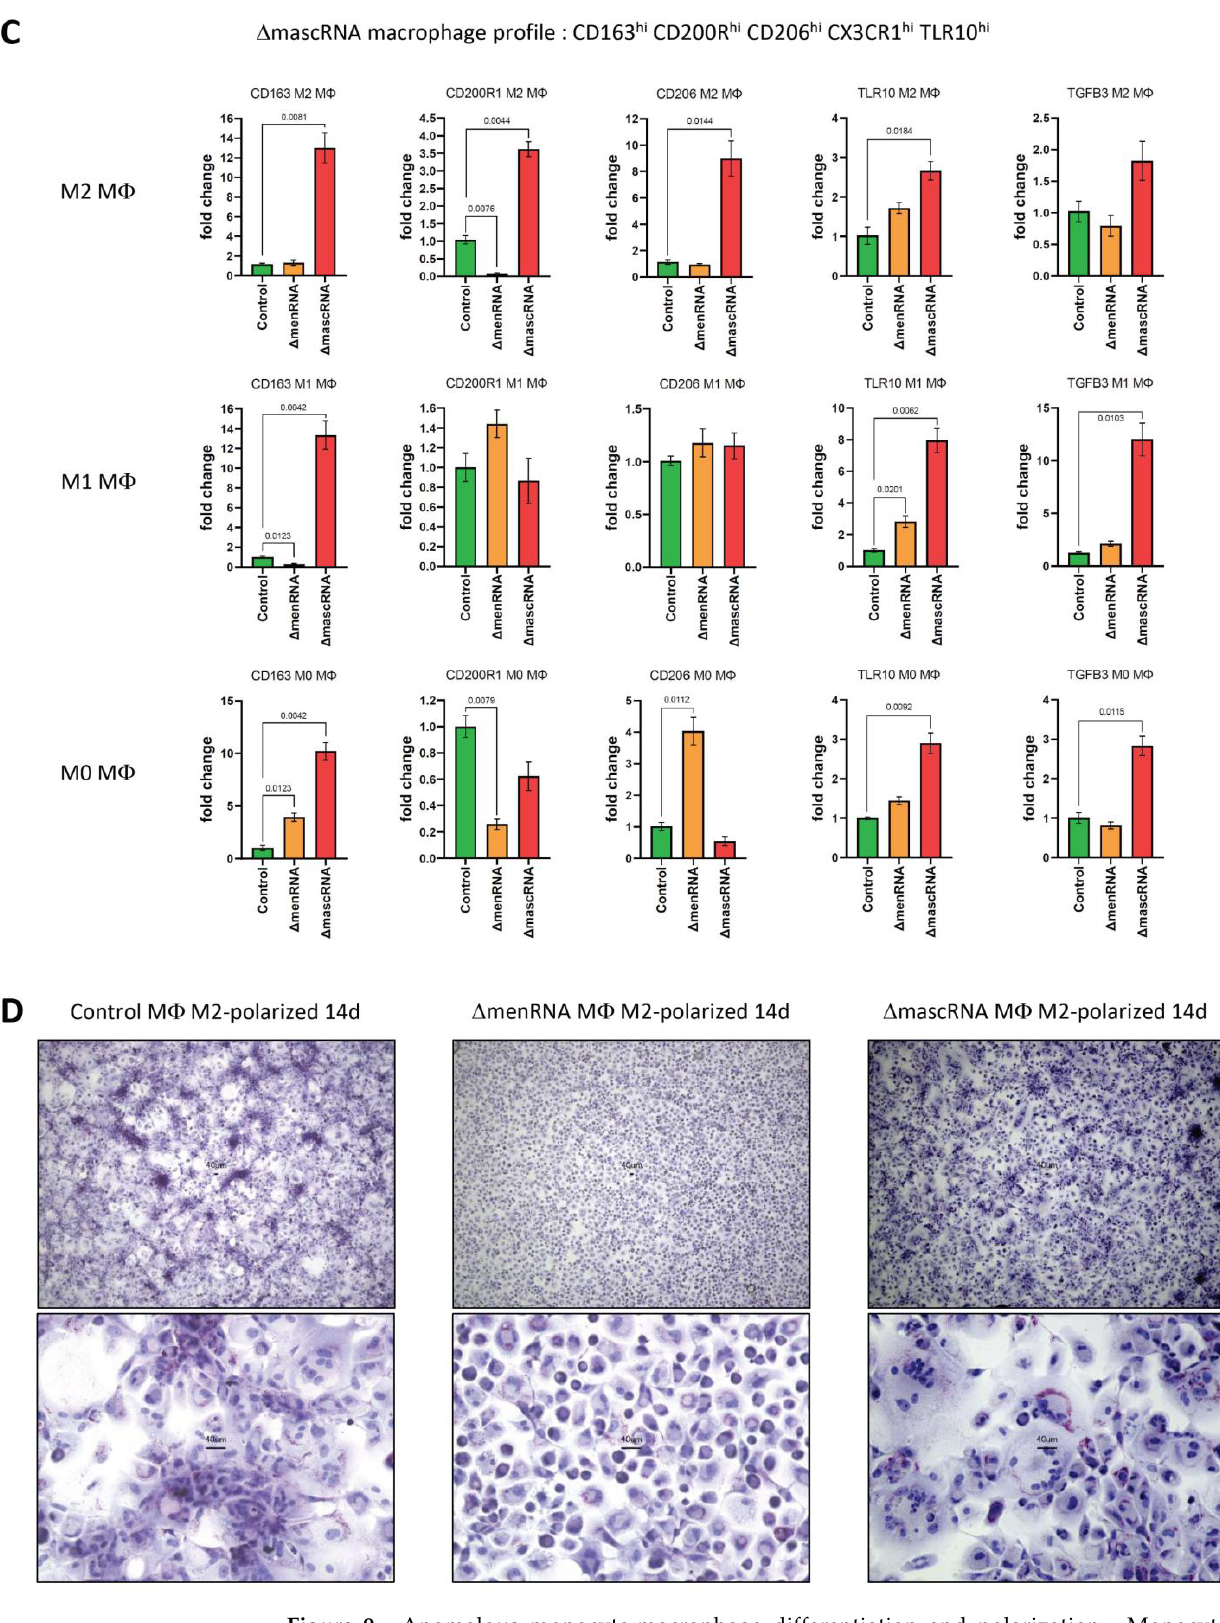
Figure 9. Anomalous monocyte-macrophage differentiation and polarization. Monocyte-M0 macrophage differentiation and subsequent M1/M2 macrophage were conducted as follows: First, M0 macrophages were generated by incubation of THP-1 monocyte clones for seven days, with PMA at a concentration of 100 ng/mL. Thereafter, the cells were further incubated for another seven